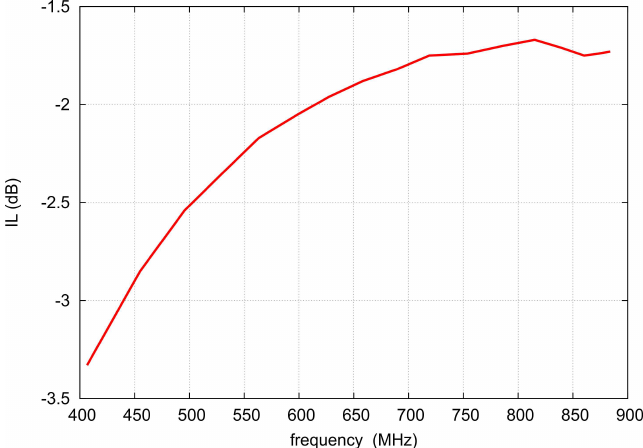
Figure 14. Variation of the insertion loss of the proposed tunable bandpass filter versus frequency.